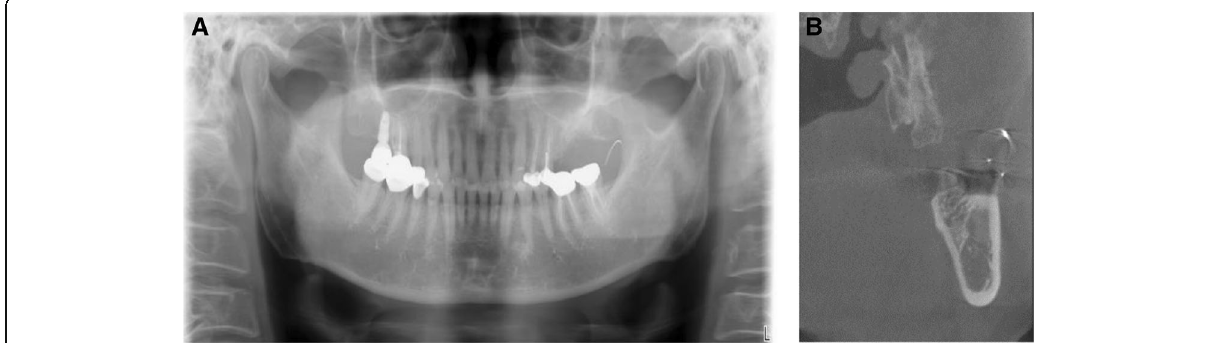
Fig. 2 A Panoramic radiograph taken on arrival shows needle fragment located at the anterior ramus of left mandible. B CBCT image of the lost needle with 2 injection needles as reference